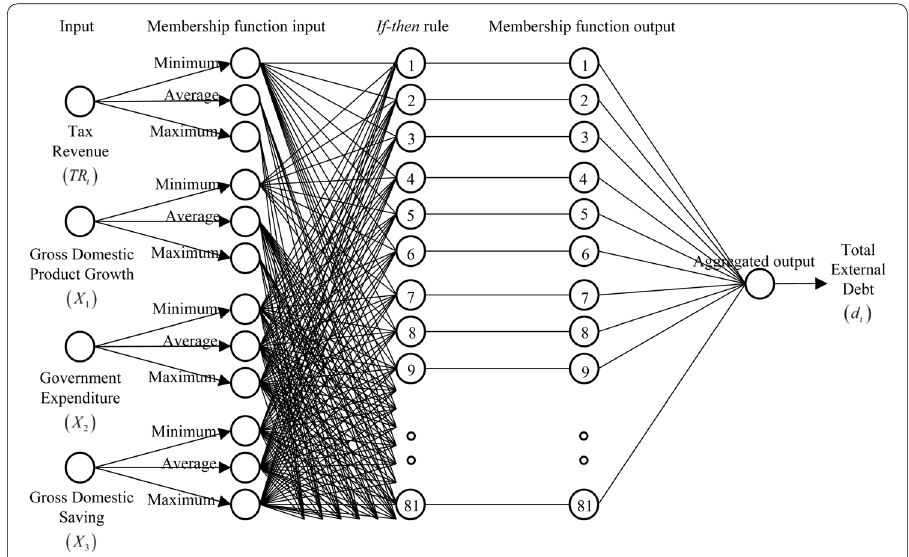
Fig. 1 The basic architecture of the ANFIS model to predict the external debt in